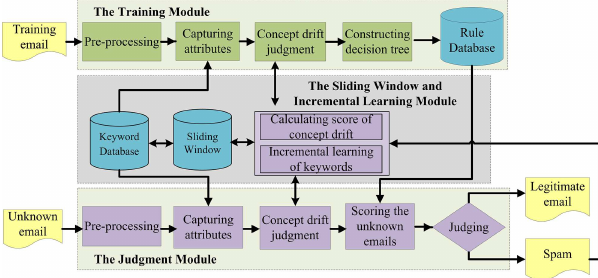
Fig 1. The architecture of our email filtering